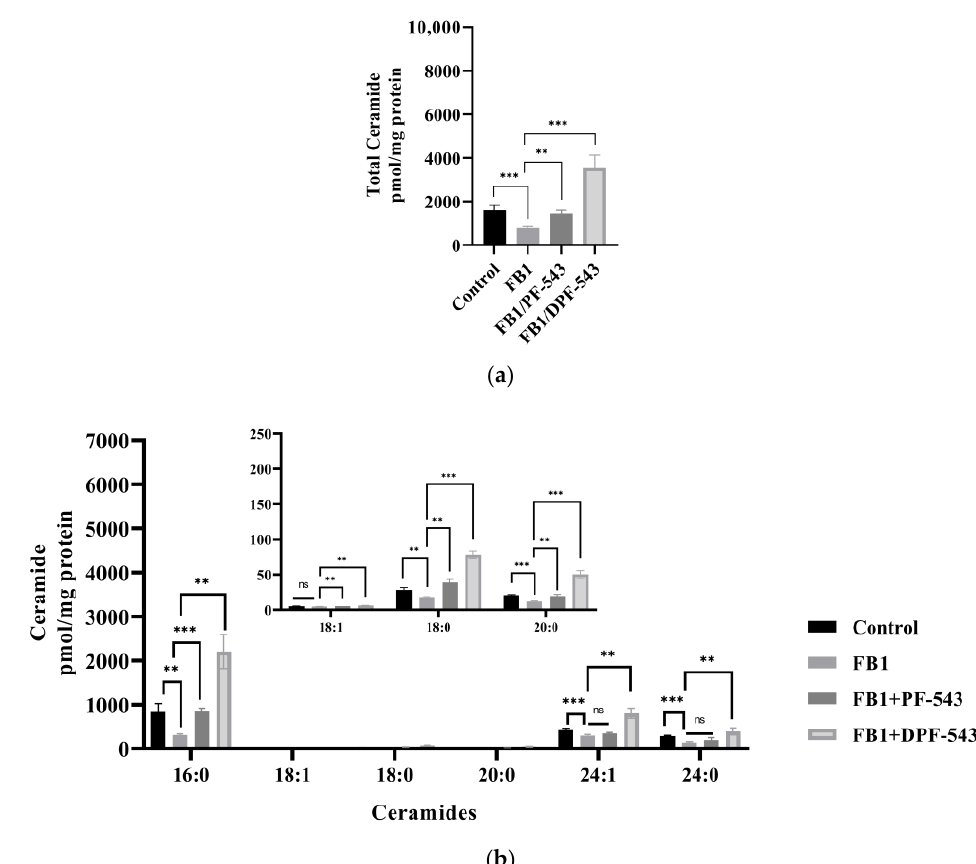
Figure 8. ( a ) PF-543 and DPF-543 impact on total ceramide accumulation reduced by FB-1 treatment; ( b ) alteration of individual ceramides by PF-543 and DPF-543 after FB-1 treatment. Data are shown as means ± SD, ns—not significant, ** p < 0.01, *** p < 0.001.